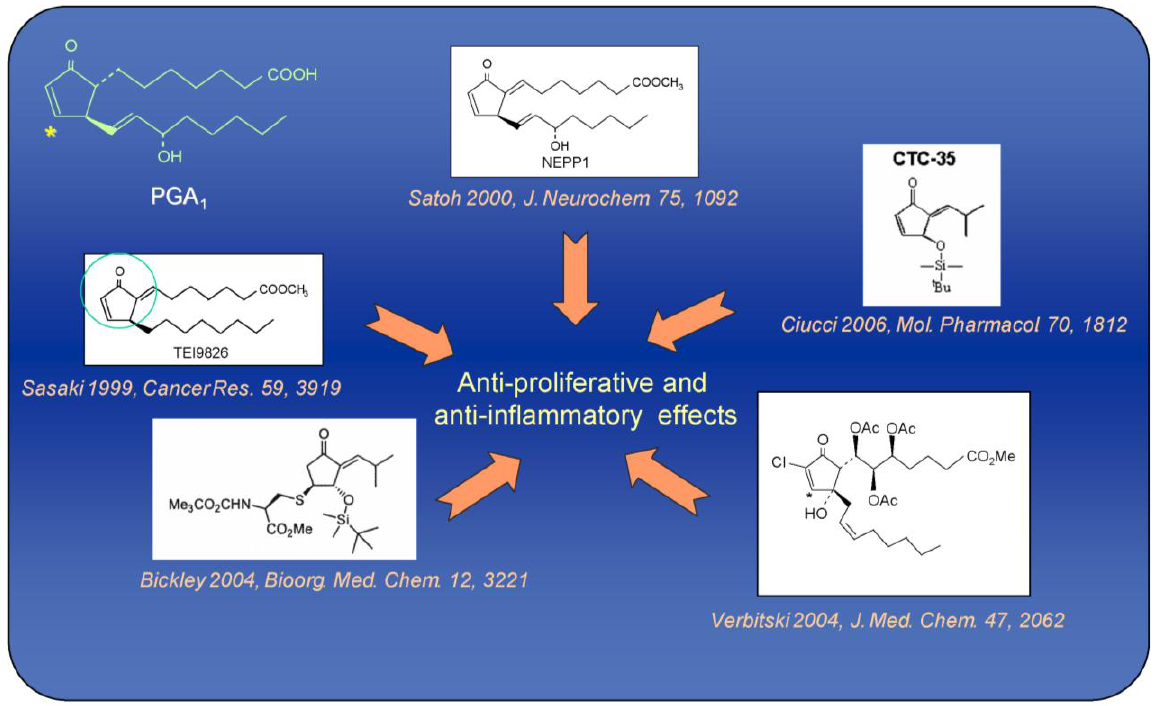
FIGURE 6. Several compounds bearing a PGA 1 -like reactive moiety that have been studied as potential anti-inflammatory or antiproliferative